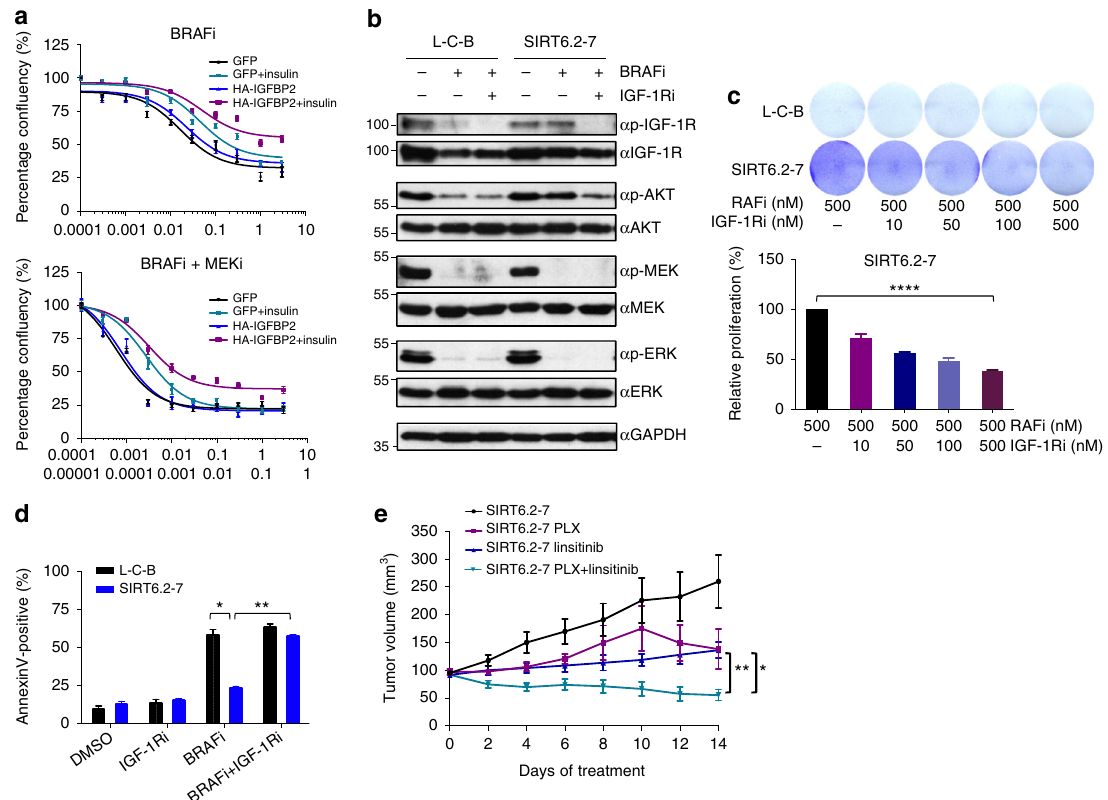
Fig. 4 Inhibition of both MAPK and IGF-1R signaling impairs drug resistance. a Growth inhibition curves for BRAFi (top) and BRAFi + MEKi (bottom) in the indicated conditions ( µ M) after 72 h, n = 3. Data are mean ± SEM. b The effects of BRAFi or BRAFi + IGF-1R/IRi treatment on components of IGF-1R, AKT, and ERK signaling pathways in the indicated CRISPR cell lines. Levels of pIGF-1R, total IGF-1R, pAKT, total AKT, pMEK, total MEK, pERK, and total ERK shown after 4 days ± 0.5 µ M BRAFi or 0.5 µ M BRAFi + 0.5 µ M IGF-1R/IRi. GAPDH used as a loading control. c Indicated cell lines were seeded at the same density and cultured for 1 week in presence of the indicated compounds (top). Relative cell proliferation (percentage) of the same cells, n = 3. Data are mean ± SEM; **** P < 0.0001; Paired two-tailed Student ’ s t -test was performed for comparisons (bottom). d L-C-B and SIRT6.2 – 7 cells were treated with DMSO, IGF-1R/IRi (2 µ M), BRAFi (0.5 µ M), or both at 0.5 µ M for 72 h. Percentages of Annexin-V positive cells indicated, n = 3. Data are mean ± SEM; * P < 0.05, ** P < 0.01 Paired two-tailed Student ’ s t -test was performed for comparisons. e Quanti fi cation of tumor volume in nude mice bearing